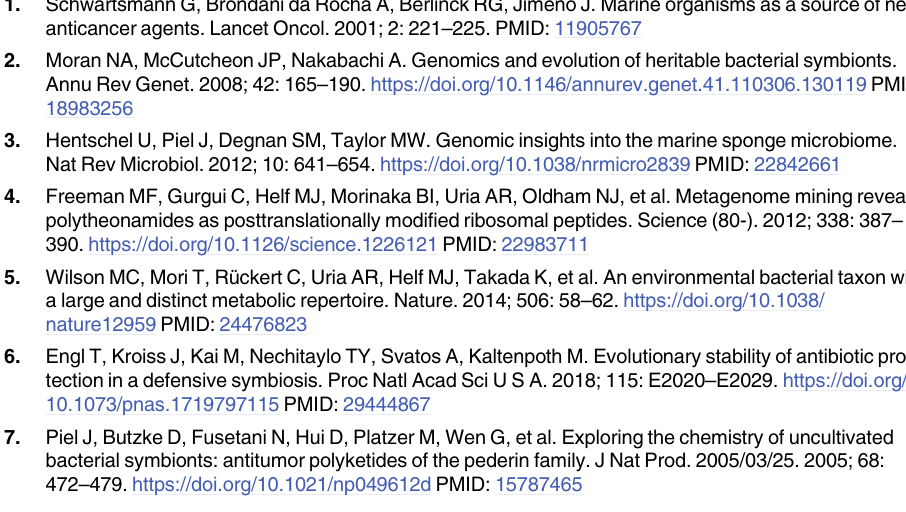
S1 Table. Absorbance of sulforhodamine B at a wavelength of 515